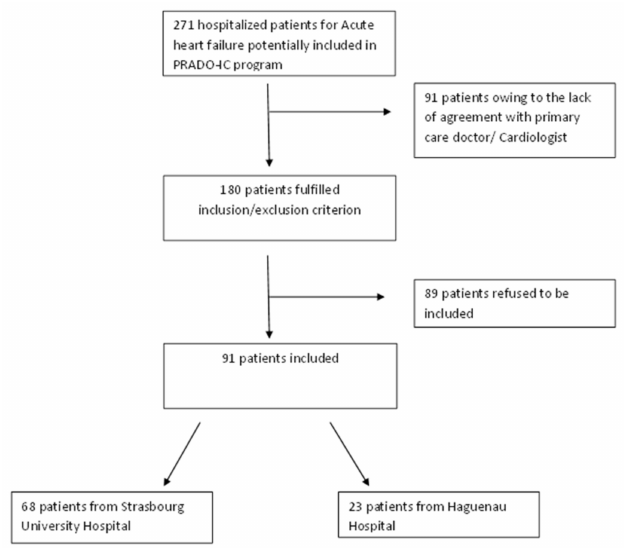
Figure 1. Patient’s flow